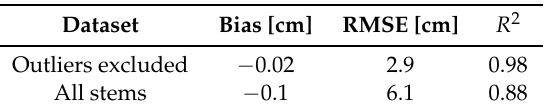
Figure 4. Correlation between reference DBH and estimated DBH. The samples marked with squares are outliers. The coefficient of determination R 2 and the related linear model is given both for all stems and for the same dataset with outliers excluded. Table 1. Overview of the verification results for the final dataset with outliers being excluded and the original dataset including all